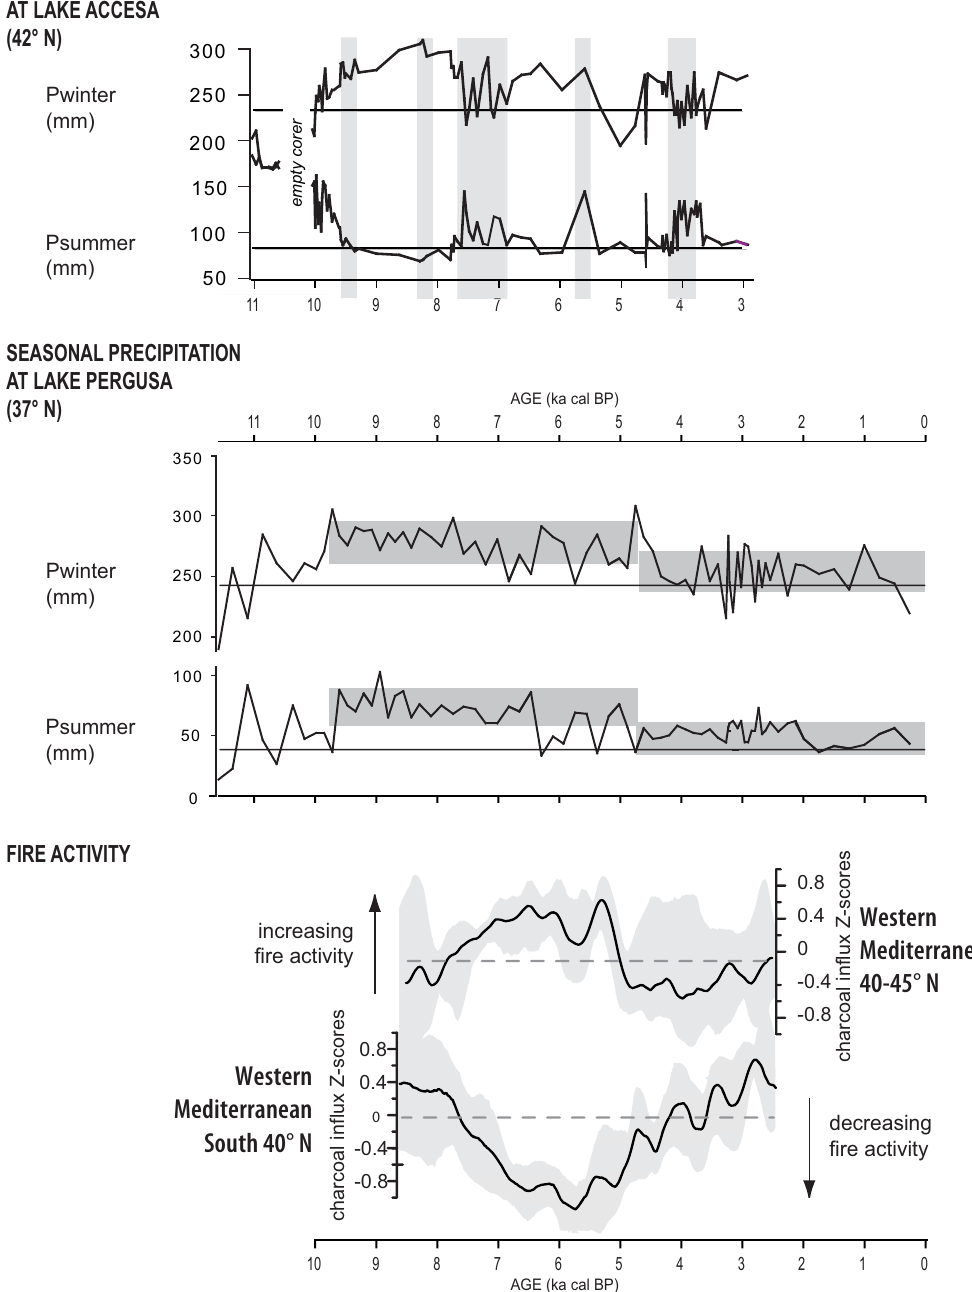
Fig. 4. (Top) Pollen-inferred estimates of seasonal precipitation at Lake Accesa (Peyron et al., 2011) and Lake Pergusa (Magny et al., 2012c; Peyron et al., 2013). (Bottom) Changes in fire regimes in north- and south-western Mediterranean (Vanni`ere et al., 2011).